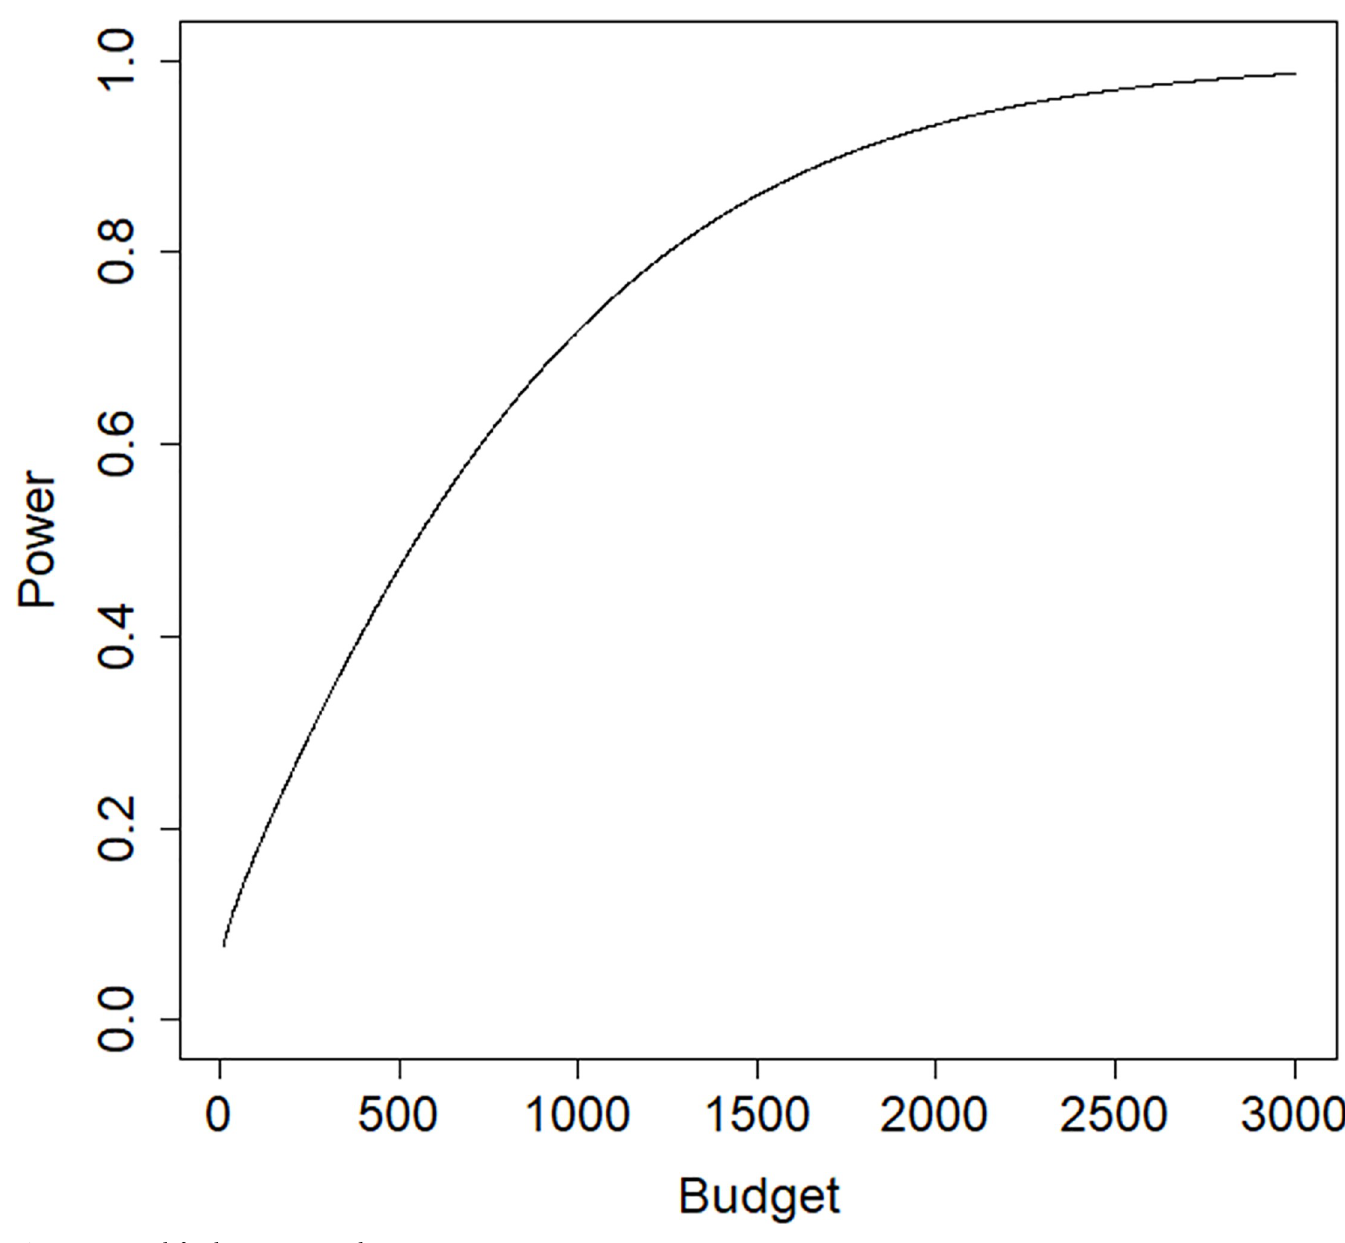
Fig 7. Power graph for the trauma